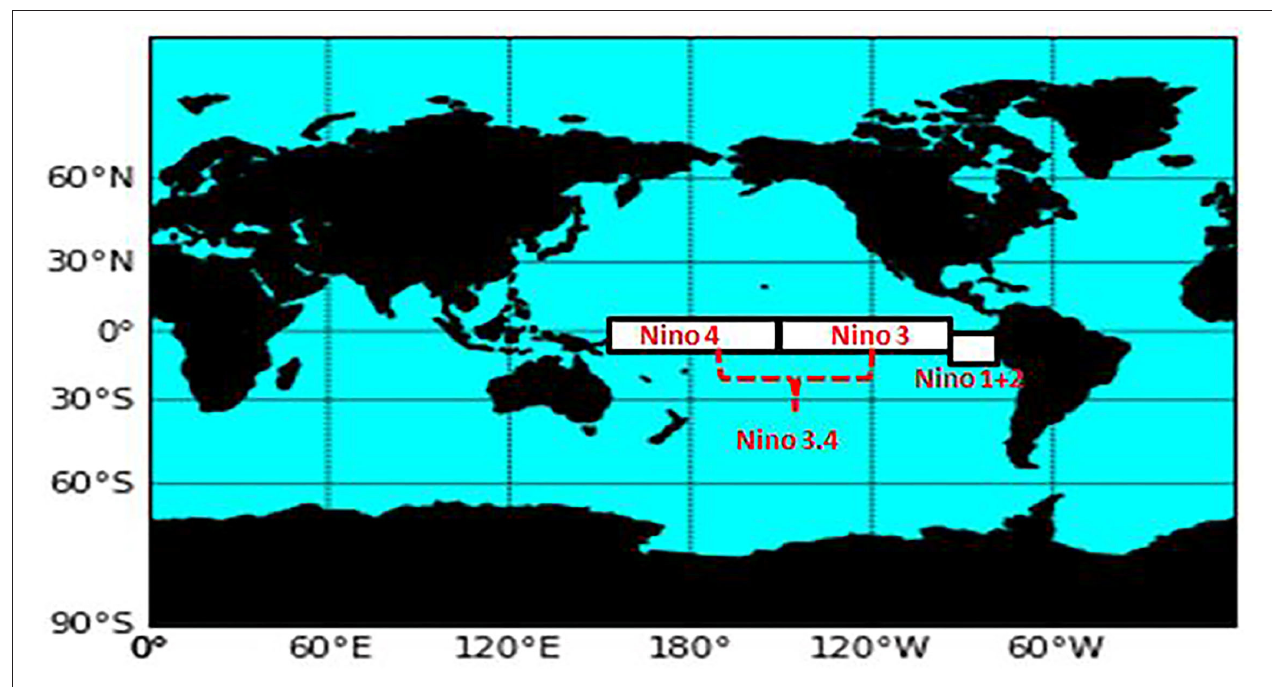
FIGURE 2 | Niño SST indices